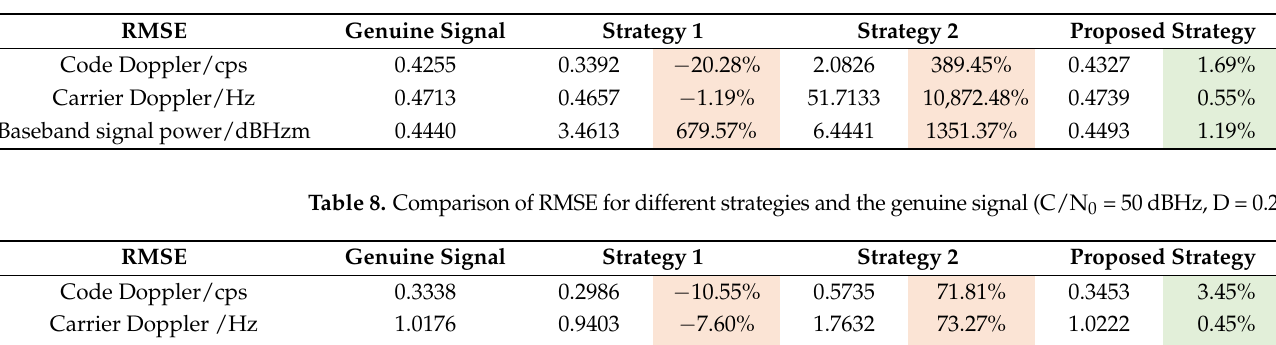
Figure 20. Tracking results of the proposed strategy (( C/N